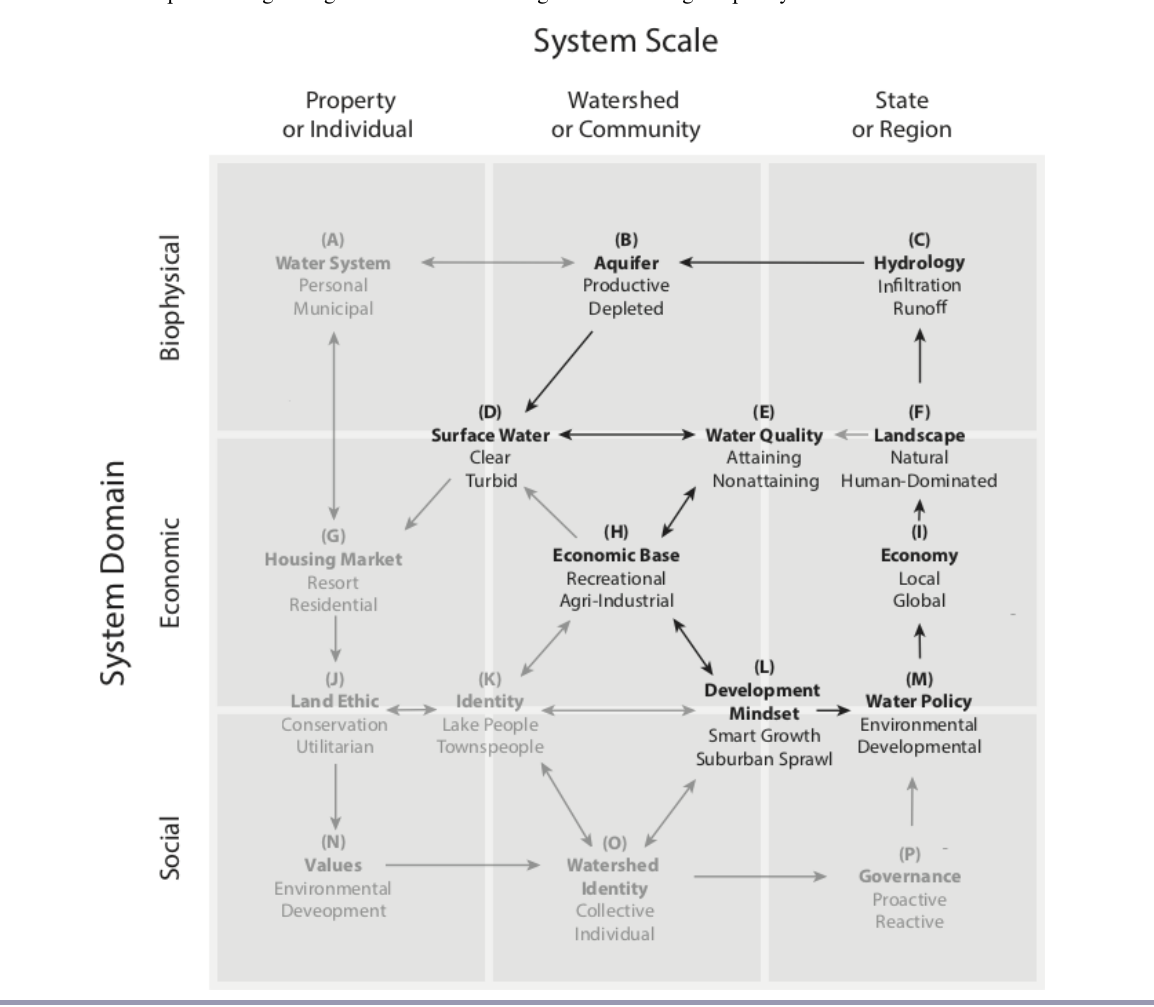
Fig. 3 . The policy-development dynamic where a sprawling development mindset creates the need for lax policies regarding the environmental regulations for high capacity